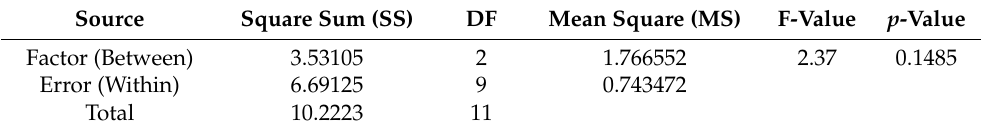
Table 17. Effect of S fiber type and temperature on f R,b by applying ANOVA analysis. Source Square Sum (SS) Factor